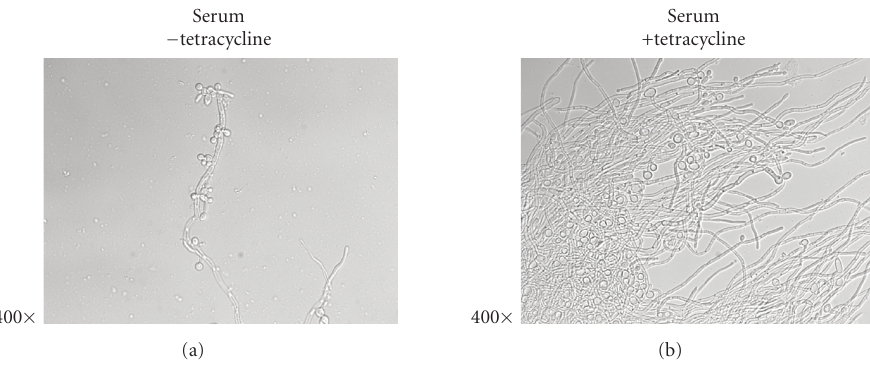
Figure 3: Photomicrographs of Candida albicans (Strain GT142) grown overnight at 37 ◦ C in serum or serum plus tetracycline (5 μ g/mL). The tendency of tetracycline to enhance filamentous growth is particularly evident in the right-hand